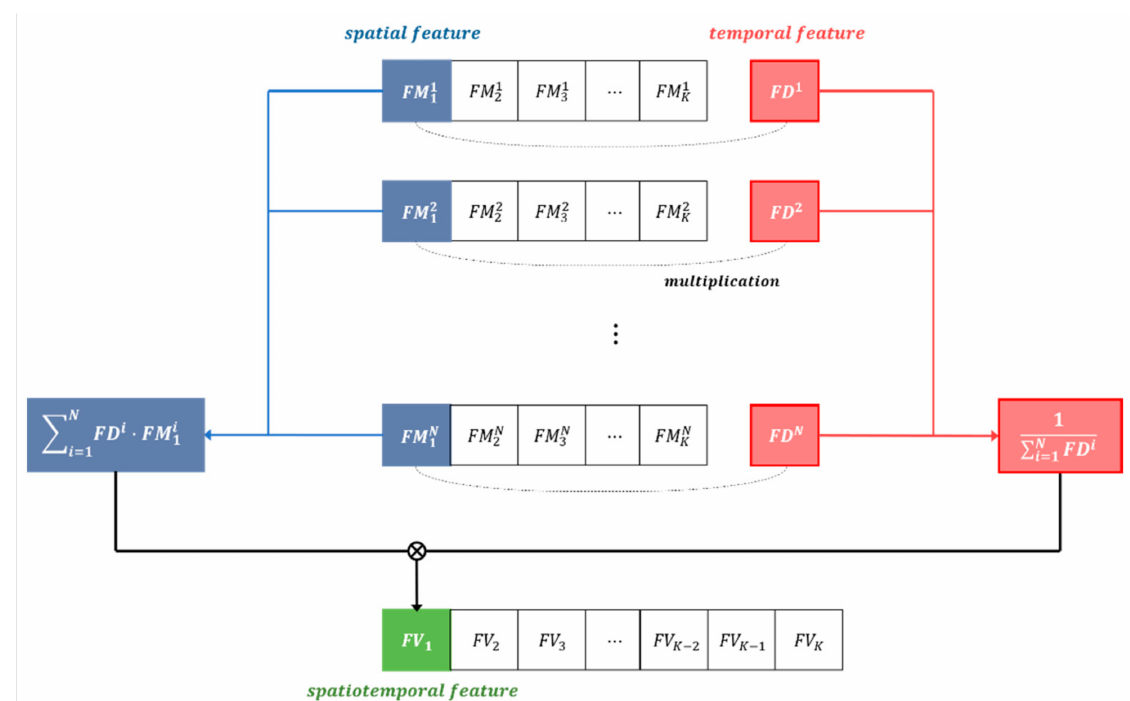
Figure 4. Process for generating weighted mean-based spatiotemporal